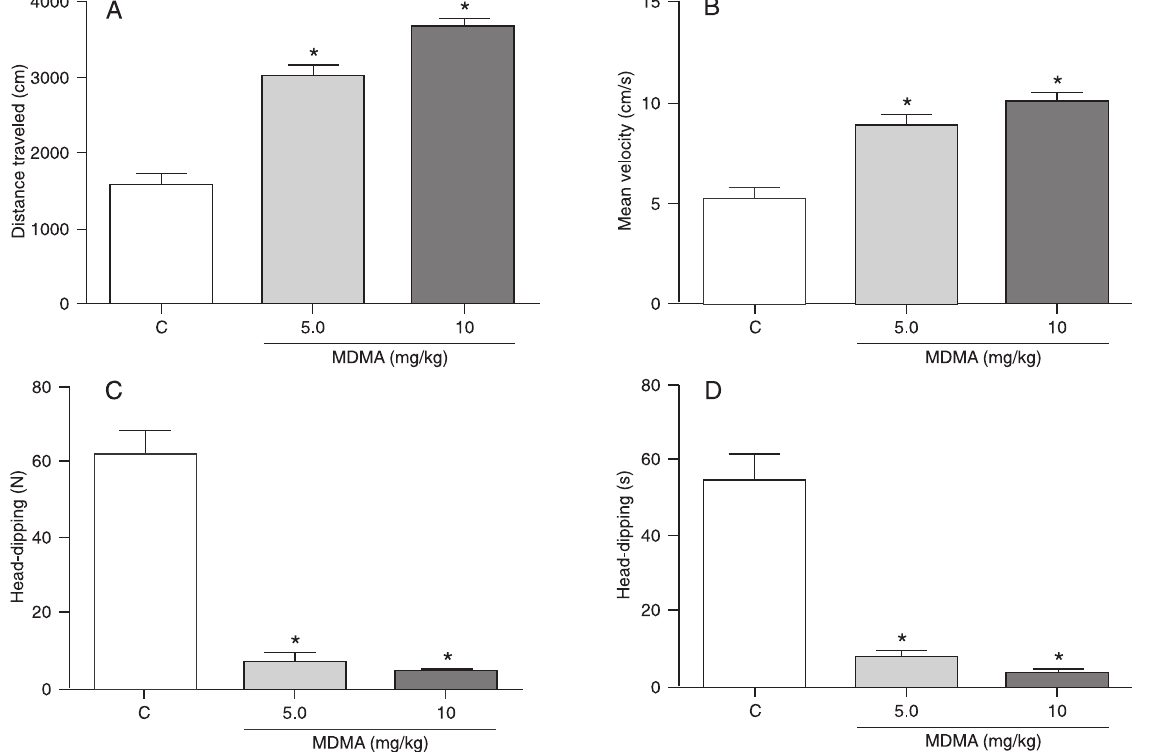
Figure 2. Behavioral effects of 3,4-methylenedioxymethamphetamine (MDMA) on BALB/c male mice in the hole-board test. A , Distance traveled (cm); B , mean velocity (cm/s); C , number of head dips; D , time spent during head-dipping. Data are reported as means ± SEM for 10 animals/group. *P < 0.05 compared to control group (one-way ANOVA followed by Dunnett’s multiple comparison test).